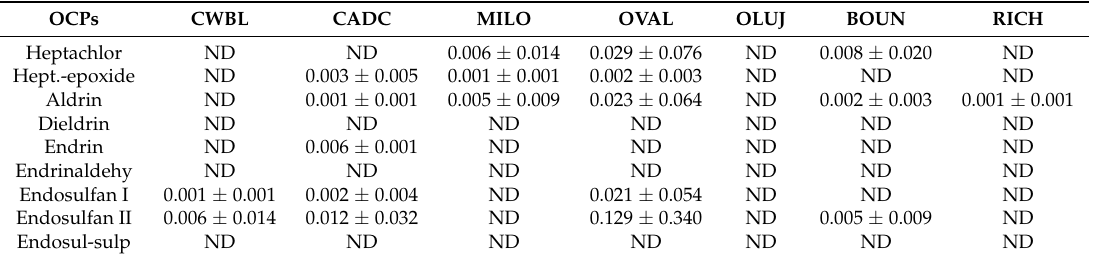
Table 4. Mean concentration (mg/kg) of cyclodienes in the cocoa beverages. OCPs CWBL CADC MILO OVAL OLUJ BOUN RICH